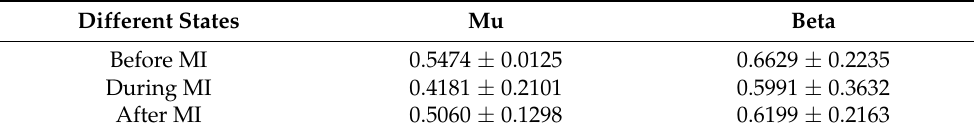
Table 3. Average global efficiency in three states of motion imagery in mu/beta